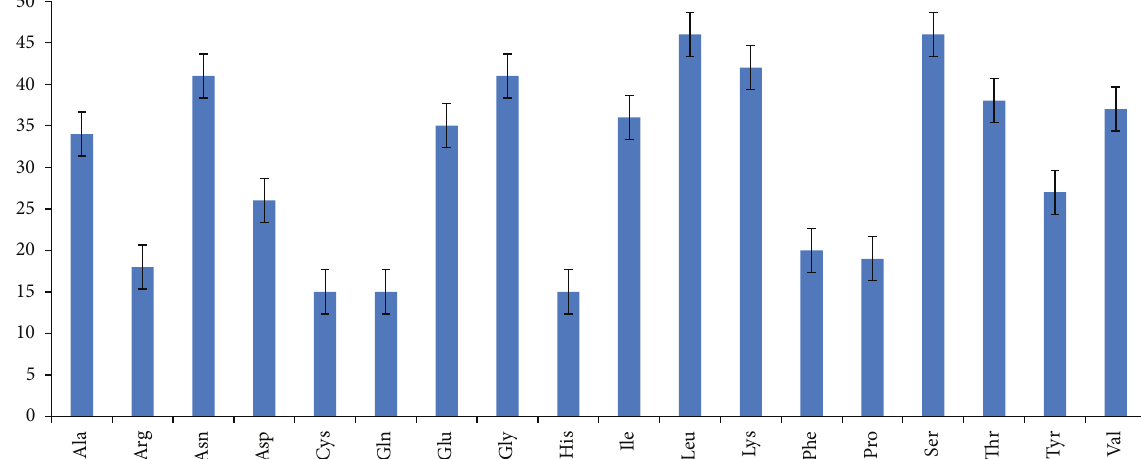
Figure 3: Frequency of the amino acid usage in the genes under study. Leucine and serine are clearly the most frequent amino acids.